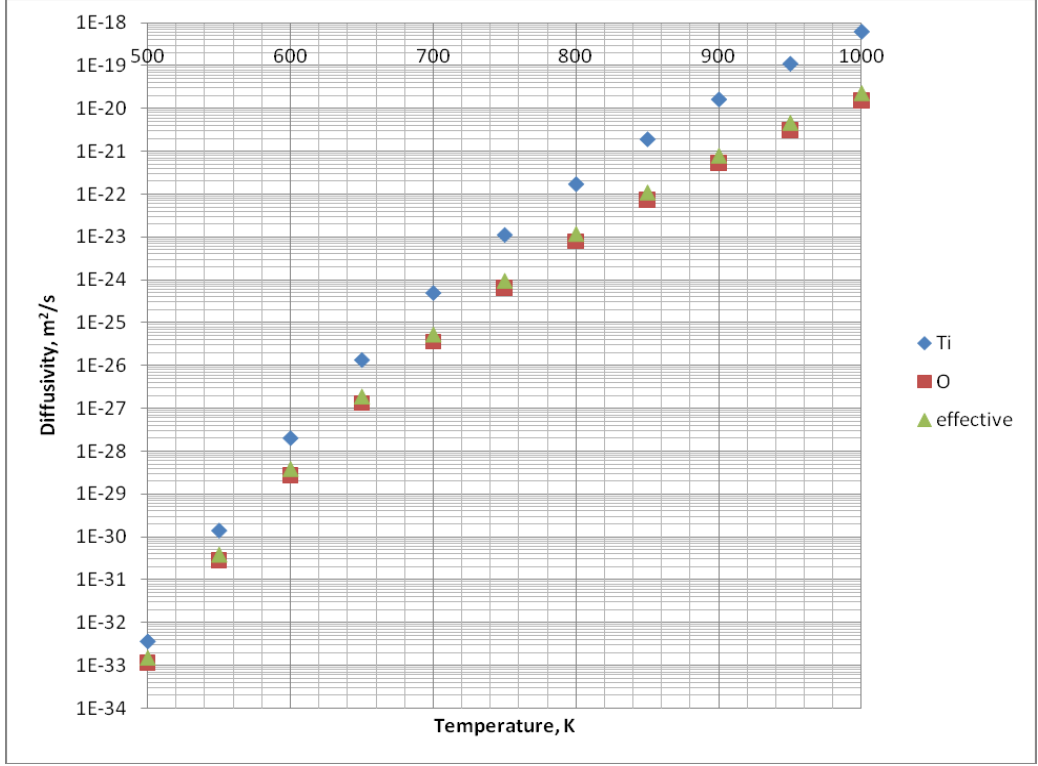
Figure 8. Diffusivity of Ti + and O - in TiO vs. temperature (see the explanation in the